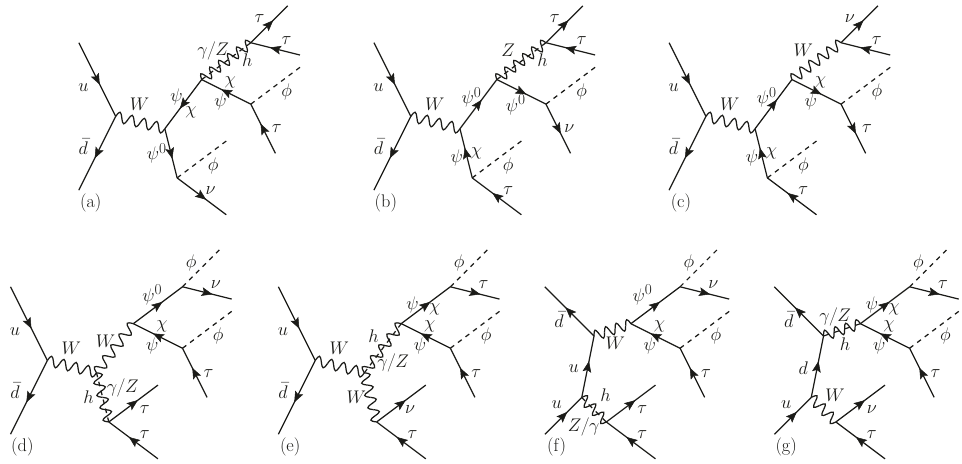
Figure 6 . Feynman diagrams contributing to the 3 τ ν 2 φ channel at the LHC. (i) The upper panel shows the W -mediated s -channel processes through q ¯ q 0 → ψ 0 ψ + ( χ + ) channel; and (ii) the lower panel, W -mediated s -channel as well as quark-mediated t -channel processes through q ¯ q 0 → W Z ( γ ) and q ¯ q 0 → W h channels. The diagrams of the lower panel are seen to be suppressed, which makes the 3 τ ν 2 φ channel predominantly W -mediated.